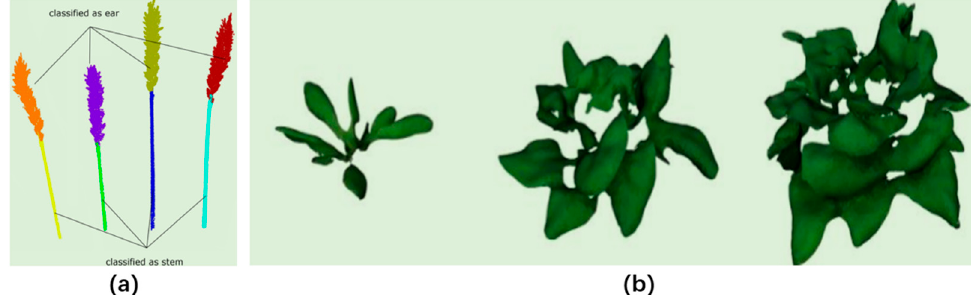
Figure 10. ( a ) A description of the concave wheat ears with segmental point clouds [102]; ( b ) The triangulation results of three different sized plants, and the triangle vertexes extracted from triangular mesh were used as the points to construct tetrahedrons, which can be used to calculate volume [27].